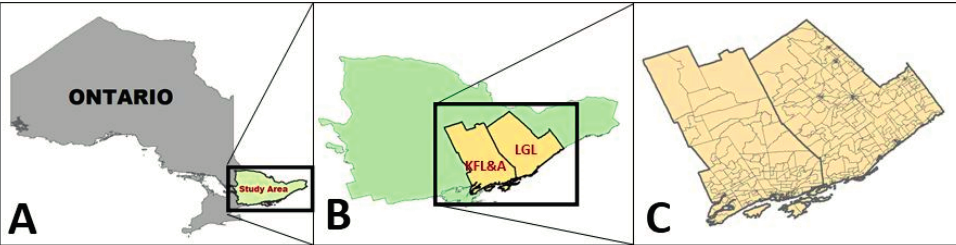
Figure 2. Extent of the tick validation study area. ( A ) The study area of the deer within the province of Ontario; ( B ) the boundaries of the two public health units with respect to the deer study area; and ( C ) the dissemination area (DA) boundaries of the two public health units. KFL&A, Kingston, Frontenac, Lexington and Addington Public Health; LGL, Leeds, Grenville and Lanark District Health